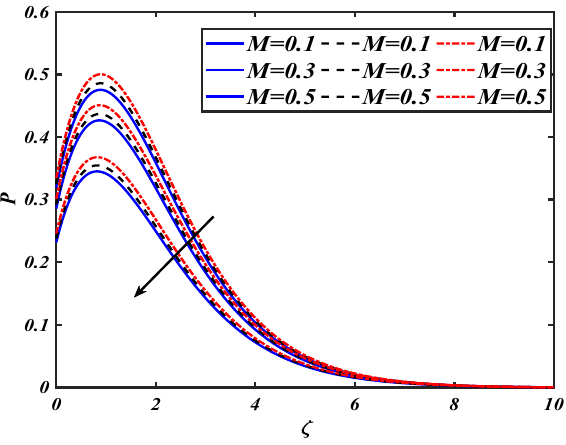
Figure 11. Pictogram of M via P .